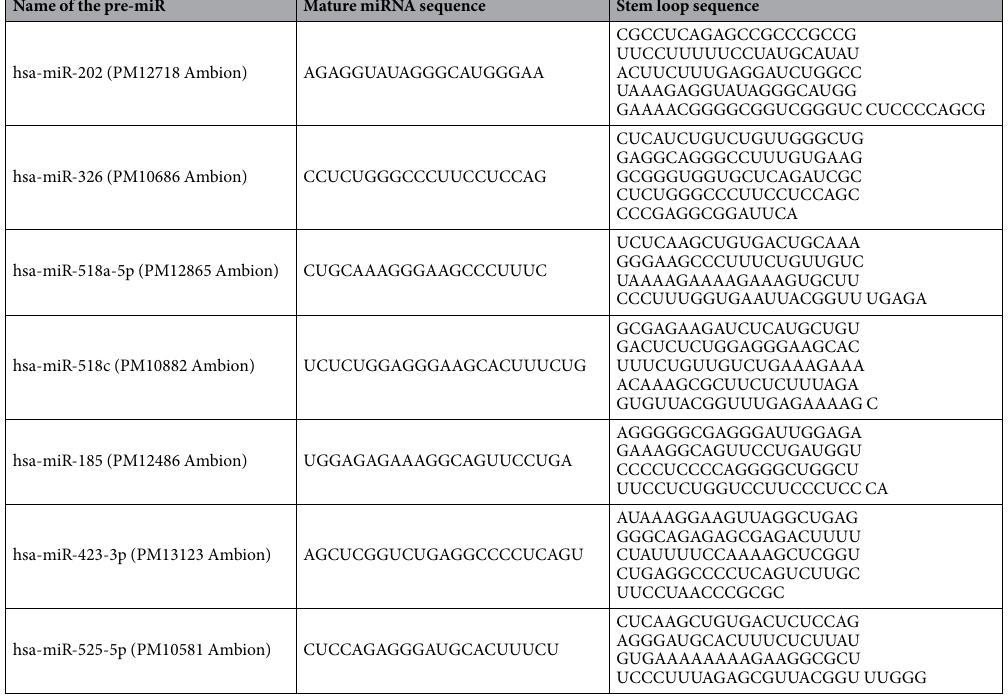
networks. Networks were prepared by collecting data regarding interacting partners of the regulated proteins derived from the String database (https://string-db.org/) and the relative expression of proteins derived from the proteomics experiments, in Cytoscape Software version 3.6.1 (Institute of System Biology, Seattle, WA, USA) which depicted the network of different pathways involved in aetiopathogenesis of vitiligo. Western blot and densitometry. The protein samples from various experiments were resolved on SDS PAGE gel in TGS buffer and then electro-blotted onto Polyvinylidene fluoride (PVDF) membrane (Millipore, USA). The blot was blocked with 5% NFDM (Non-fat dried milk)/TBST or 5% BSA/TBST for 1 hour at room temperature (RT) and probed for the proteins of interest by hybridizing with primary antibodies, secondary antibodies and loading control to detect corresponding proteins in various samples. The hybridized western blots were exposed to X-ray films for 1–2 seconds in developing cassettes in dark rooms under red light and X-ray films were developed and fixed using standard protocol. The X-ray films were scanned in HP LaserJet printer (536 dnf) and densitometry was done using Image J software. Statistical significance for the protein expression was calcu- lated using student’s t-test in Graph Pad Prism 5.0 software (Supplementary Methods for details). target validation assay for miRNA.